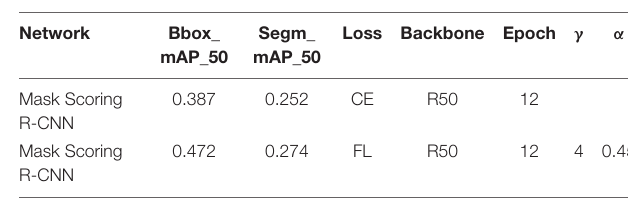
TABLE 6 | Training parameter and test results based on Mask Scoring R-CNN with different loss functions.